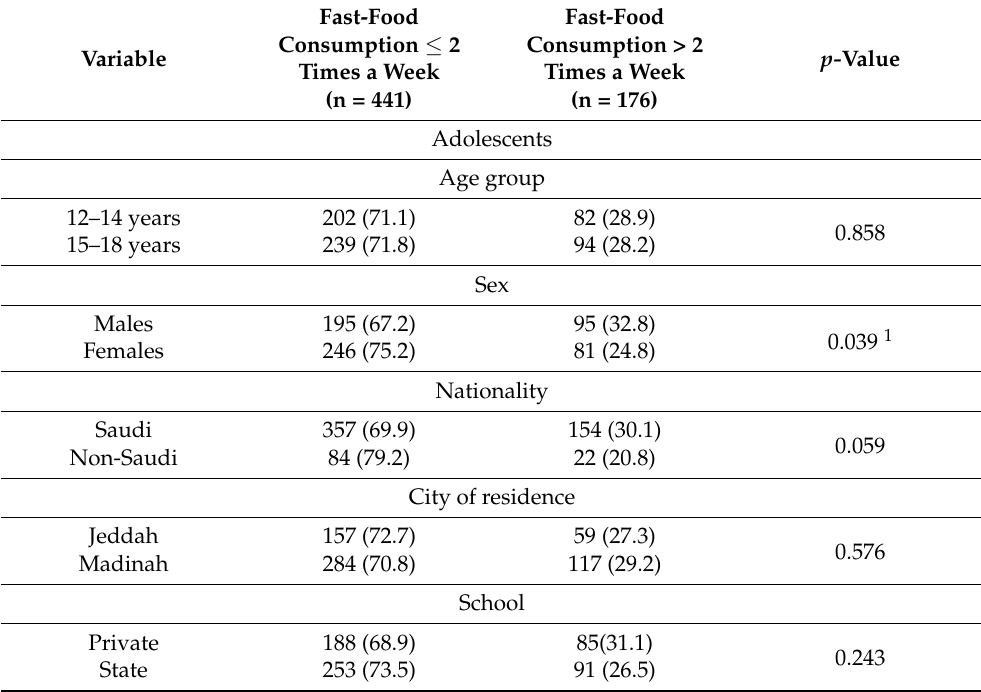
Table 1. Characteristics of participants stratified by frequency of fast-food consumption (n = 617).